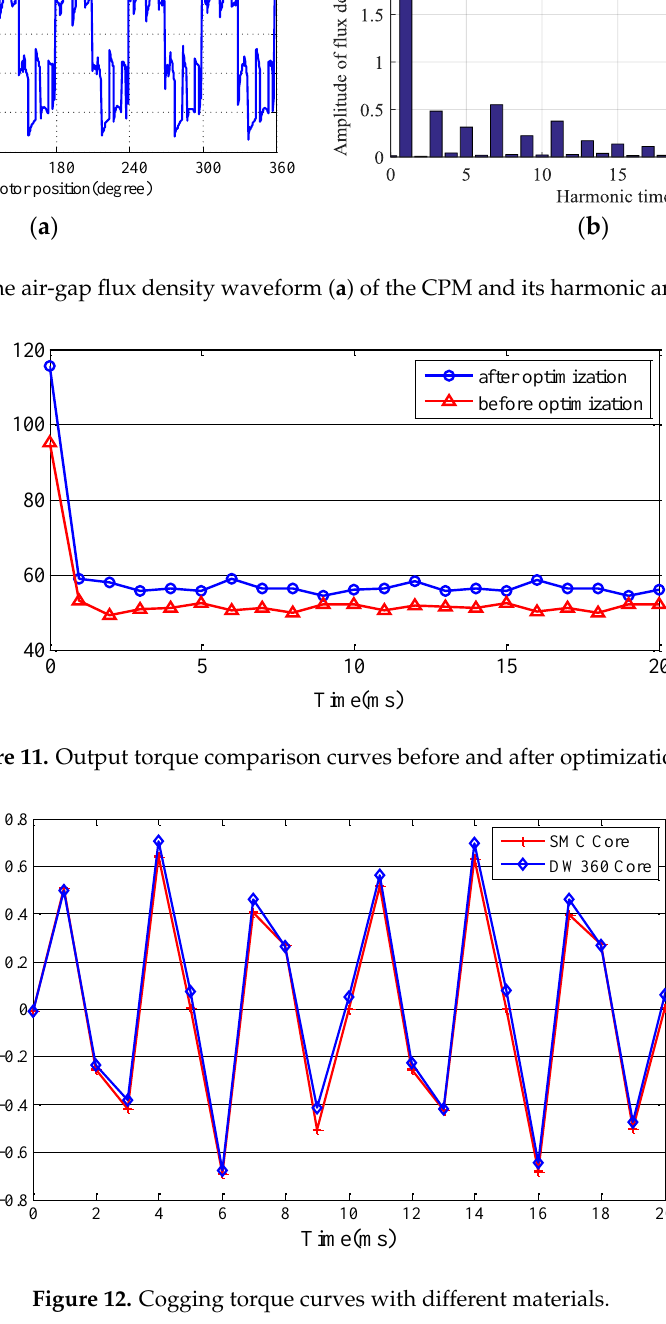
Figure 13. Core loss curves with different materials.